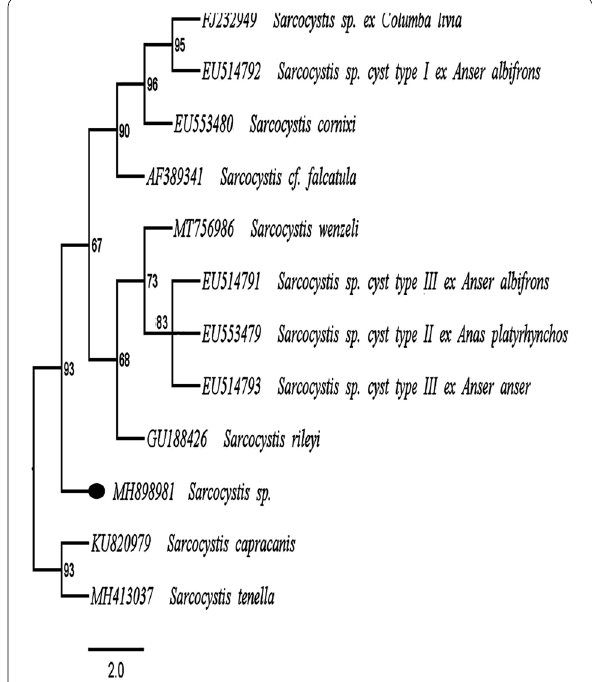
Fig. 3 Phylogenetic tree of the identified Sarcocystis sp., compared to other Sarcocystis taxa, using 28S rRNA